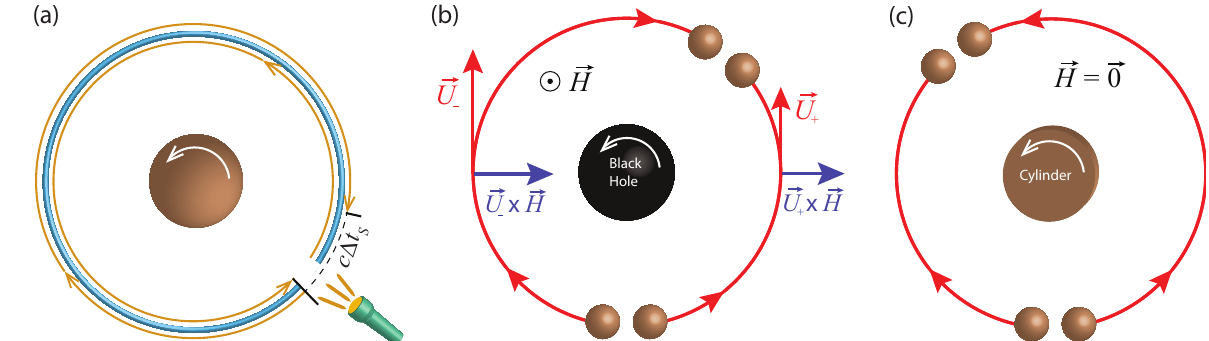
Figure 1. ( a ) Sagnac effect in an optical loop around a spinning body (dragging of the ZAMOs): a “laboratory” observer, at rest with respect to the distant stars, sends light beams propagating in opposite directions along the loop; they take different times to complete the loop, the co-rotating one arriving first, by a time difference ∆ t S < 0, Equation (7). ( b ) For particles in circular geodesics around a Kerr black hole, it is the other way around: the co-rotating one has the longer period. This is down to the combination of two oppositely competing effects: the dragging of the ZAMOs, tending to decrease the period of the co-rotating orbit vs. the gravitomagnetic force m γ (cid:126) U × (cid:126) H in Equation (9) (dragging of the compass of inertia), which is repulsive/attractive for co/counter-rotating orbits, thereby slowing/speeding up the orbit, respectively. The latter effect prevails, so that ∆ t geo = ∆ t S + ∆ t H > 0. ( c ) Around an infinite spinning cylinder of the Weyl class, (cid:126) H = 0; hence, only the dragging of the ZAMOs subsists, and the situation for circular geodesics is opposite to ( b ) [thus similar to ( a )]: the co-rotating geodesic has the shortest period, the difference reducing exactly to the Sagnac time delay, ∆ t geo = ∆ t S <